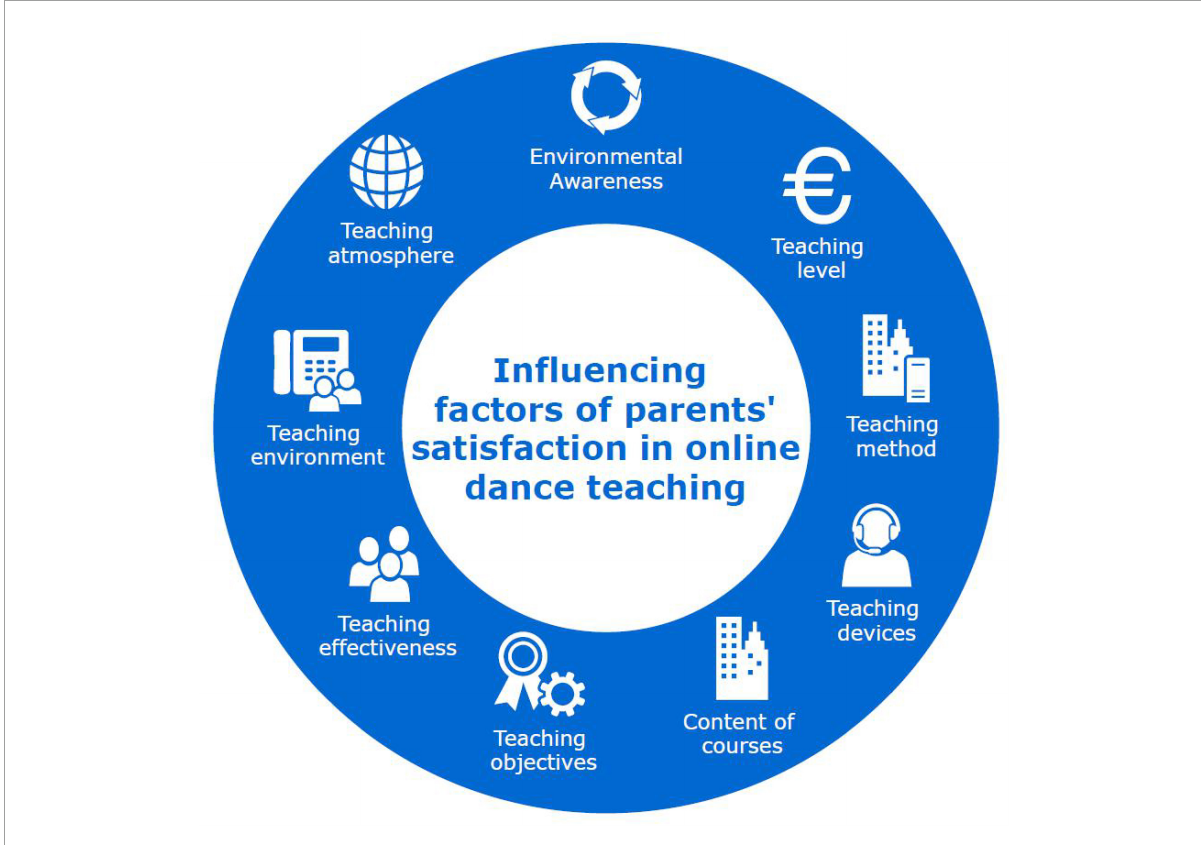
FIGURE3 Influencing factors of parents’ satisfaction in online dance